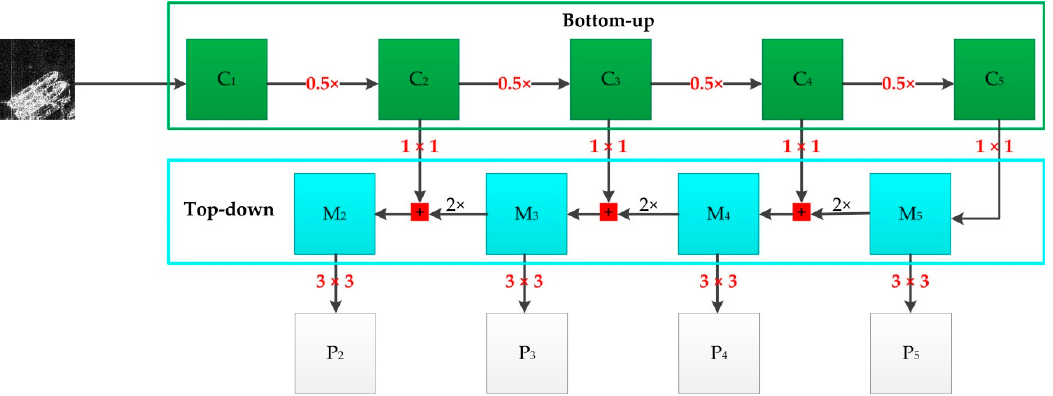
Figure 3. The architecture of FPN: C i ( i = 1,2, . . . ,5 ) is used to denote the i th convolutional building Figure 3. The architecture of FPN: 𝐶 (cid:3036) (cid:4666)𝑖 (cid:3404) 1,2,…,5(cid:4667) is used to denote the 𝑖 th convolutional building Figure 3. The architecture of FPN: 𝐶 (cid:3036) (cid:4666)𝑖 (cid:3404) 1,2,…,5(cid:4667) is used to denote the 𝑖 th convolutional building